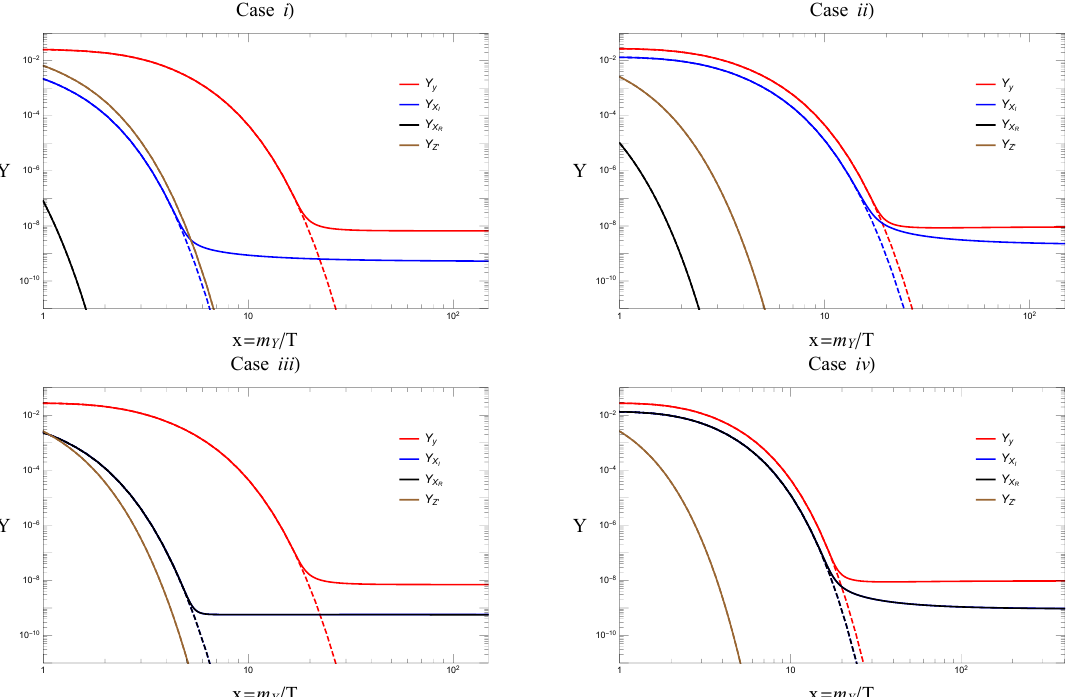
Figure 3 . The solutions of the Boltzmann equations summarised in appendix B are shown for cases i) – iv) . The red, blue, black, and brown solid lines are the yields of Y , X , X , and Z 0 , I R respectively; here Y 2 Y = 2 Y . The dashed lines correspond to the equilibrium states. In y ≡ Y Y ∗ the cases i) and ii) Y and X relics become frozen out, indicating two-component DM scenarios. I On the other hand, in the cases iii) and iv) all the DM candidates freeze out, and thus we have three-component scenarios. We note that there is no visible difference between the X relic and I X R relic in the cases iii) and iv) due to the small mass gap. A large gauge coupling g X ∼ O (1) is chosen for our benchmark points. In this case, once the mass gap becomes larger than ∼ 10 keV, a significant amount of the relic of X is converted into the X relic, mainly through X , R I R , Y → X I , Y becoming a two-component scenario. In all cases we see that Z 0 follows its equilibrium